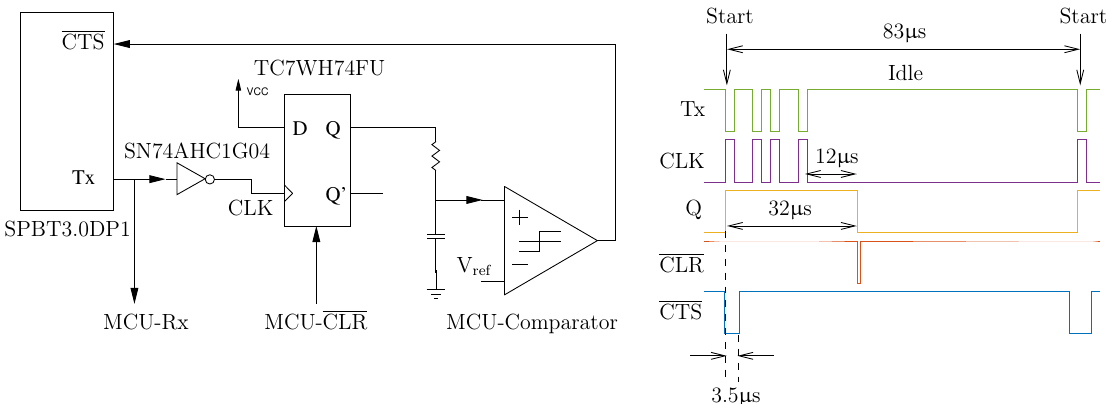
Figure 5. UART flow control circuit with a timing diagram (recorded with a logic analyzer) of a single-byte frame of a seven-byte acknowledgment